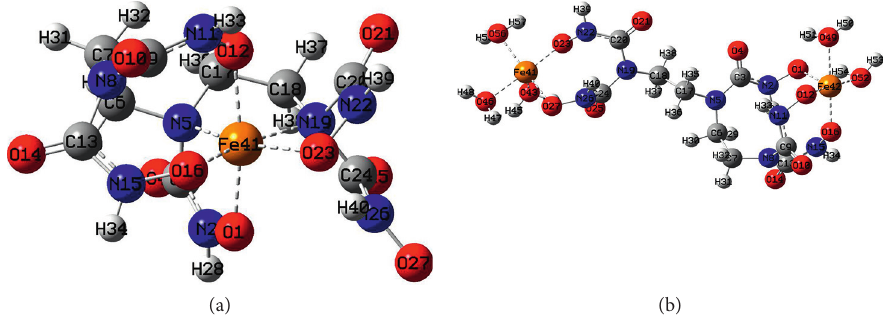
Figure 5: BOEN binding with (a) one and (b) two Fe ions.